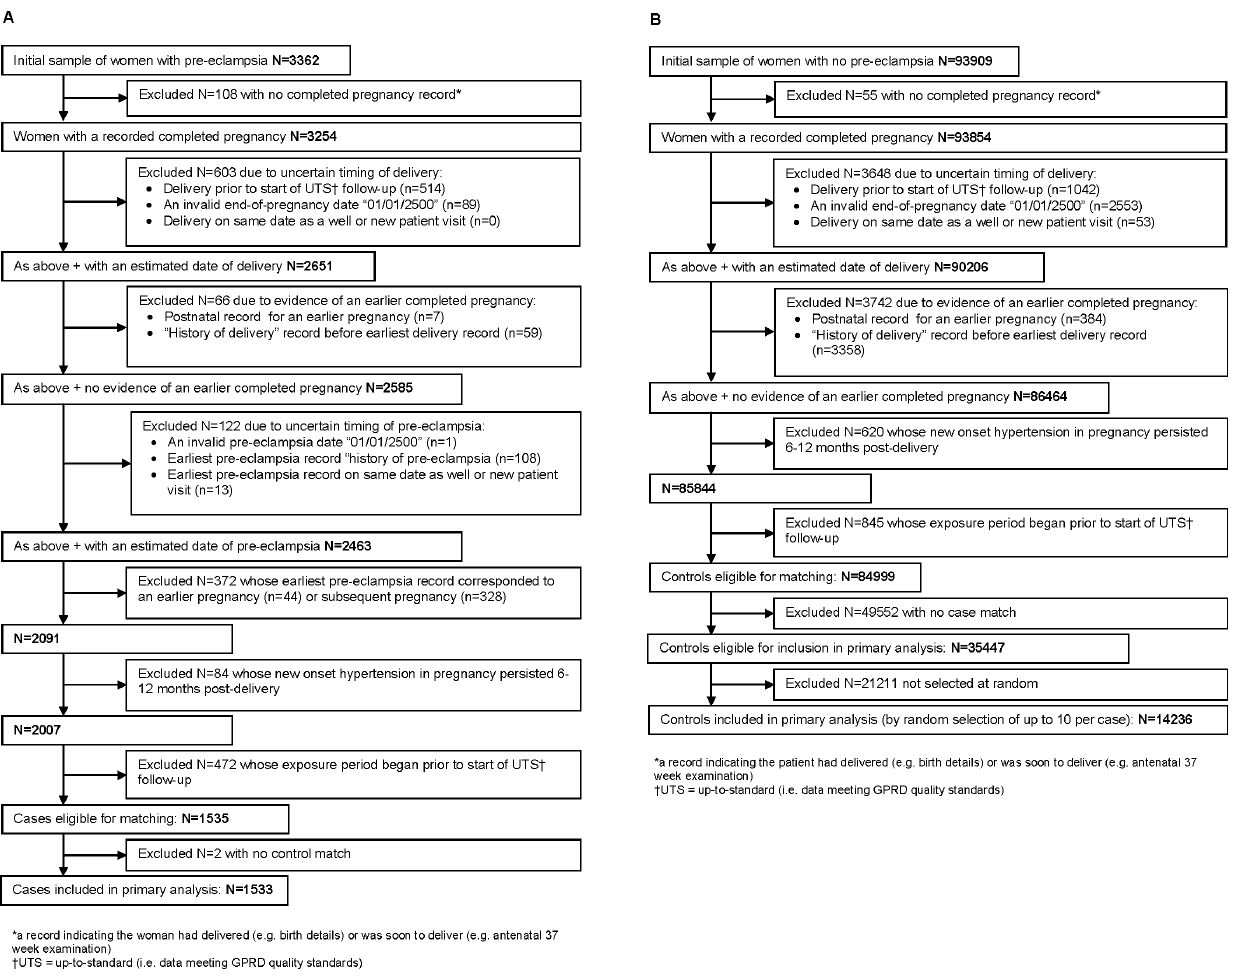
Figure 1. Identification of study participants included in the primary analysis: A) cases (n=1533); B) controls (n=14236).